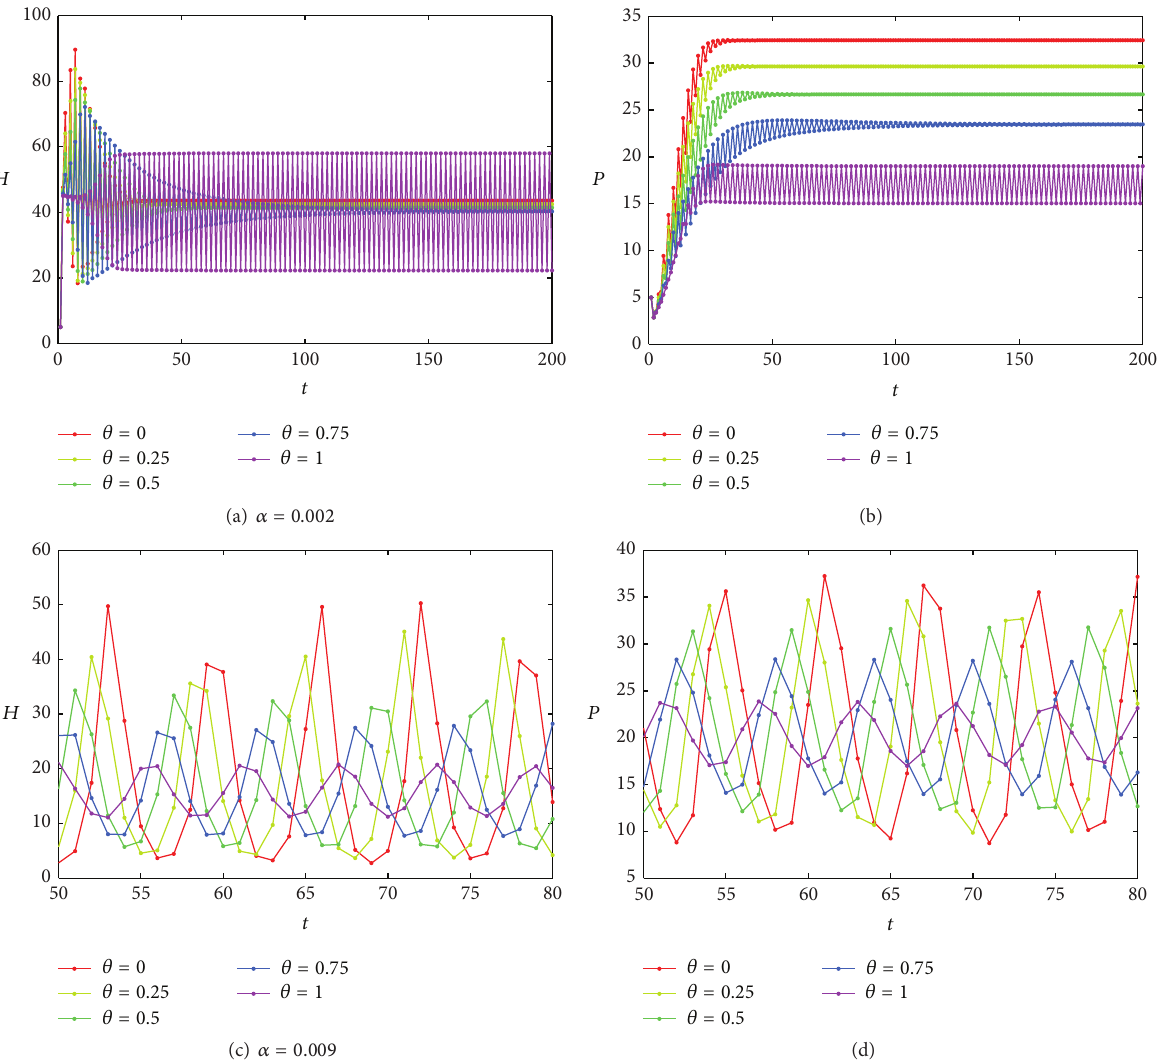
Figure 12: Sensitivity analyses of both parameter values of 𝛼 and 𝜃 . The parameter values are as follows: 𝑇 = 10 , 𝑇 ℎ = 0.5 , 𝐾 = 50 , 𝛾 = 1 , 𝛿 = 0.5 , 𝜃 = 1 , 𝑞 = 0.2 , and 𝑟 = 2.8